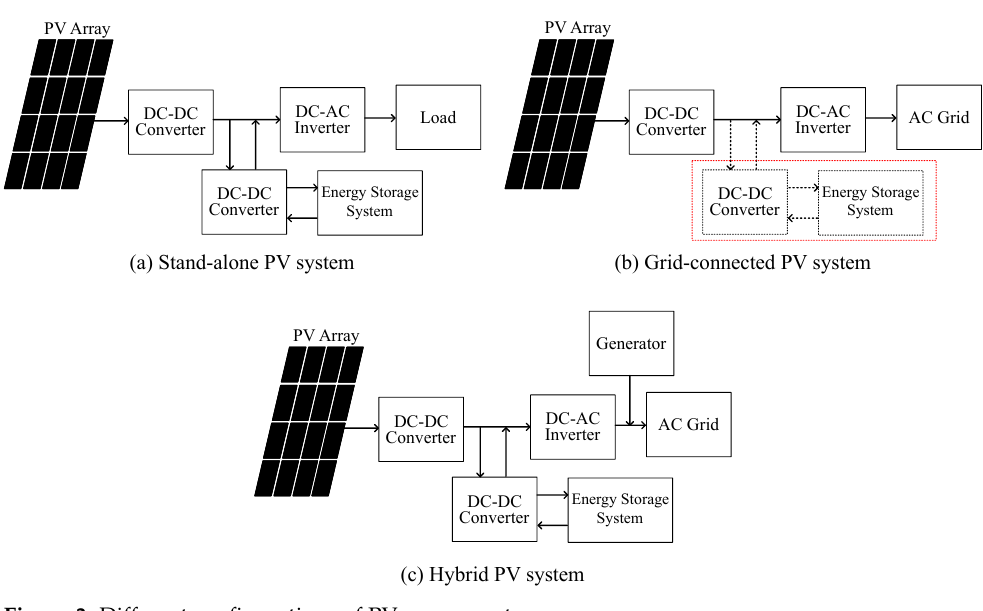
Figure 3. Different configurations of PV power